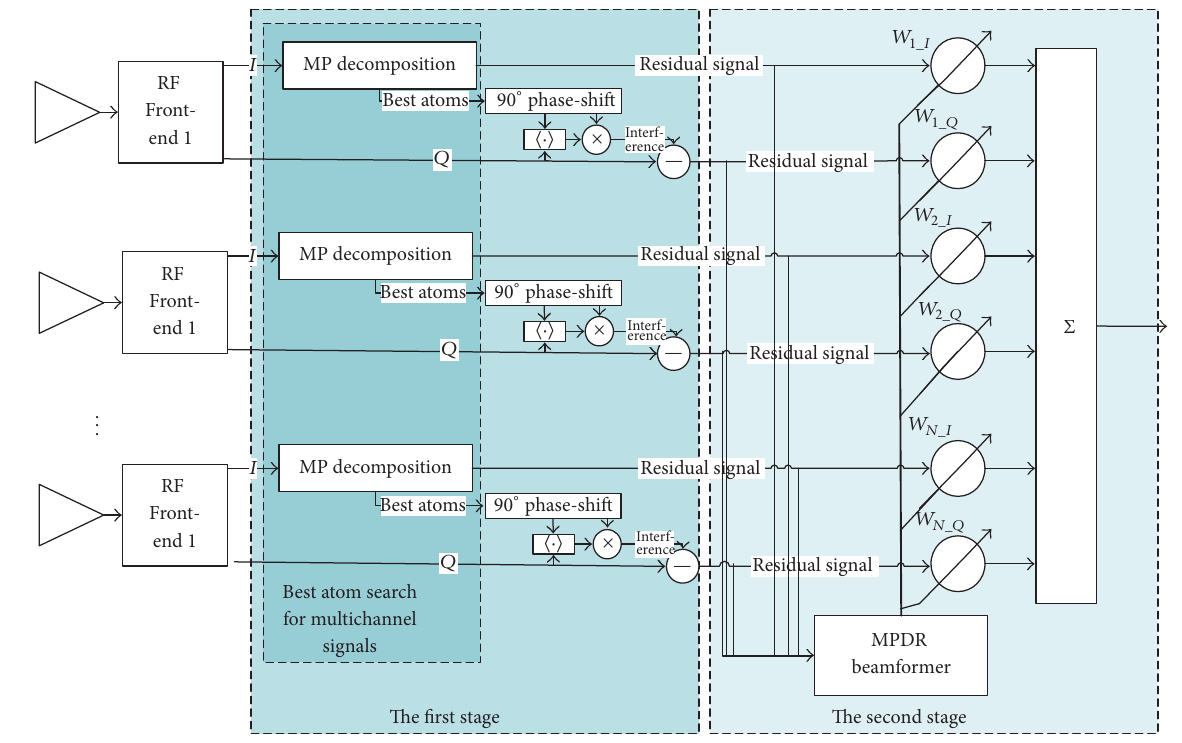
Figure 1: Block diagram of the proposed